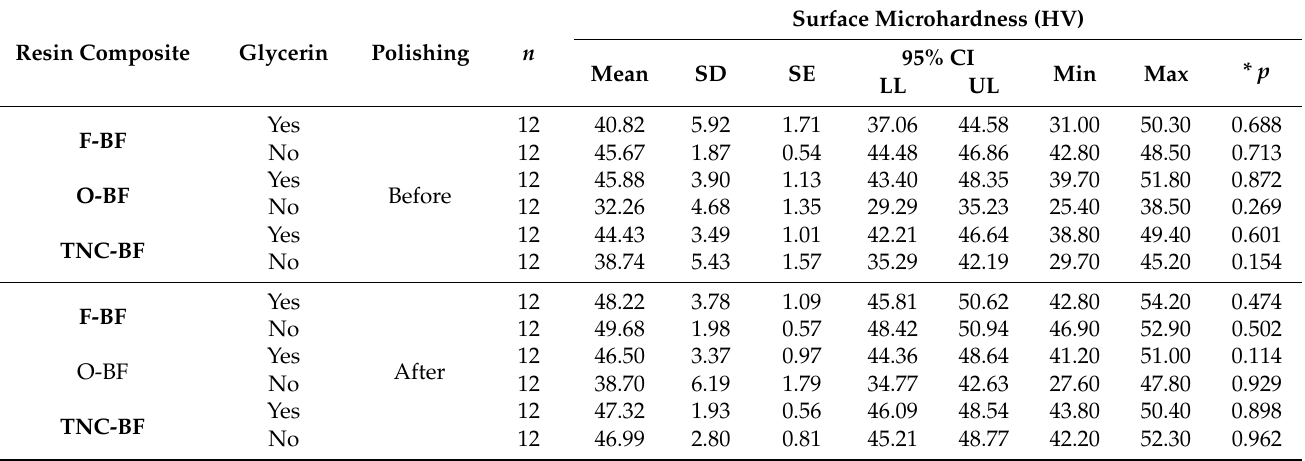
Table 3. Analysis of surface microhardness (HV) values, before and after polishing, of bulk-fill resin composites with and without OIL